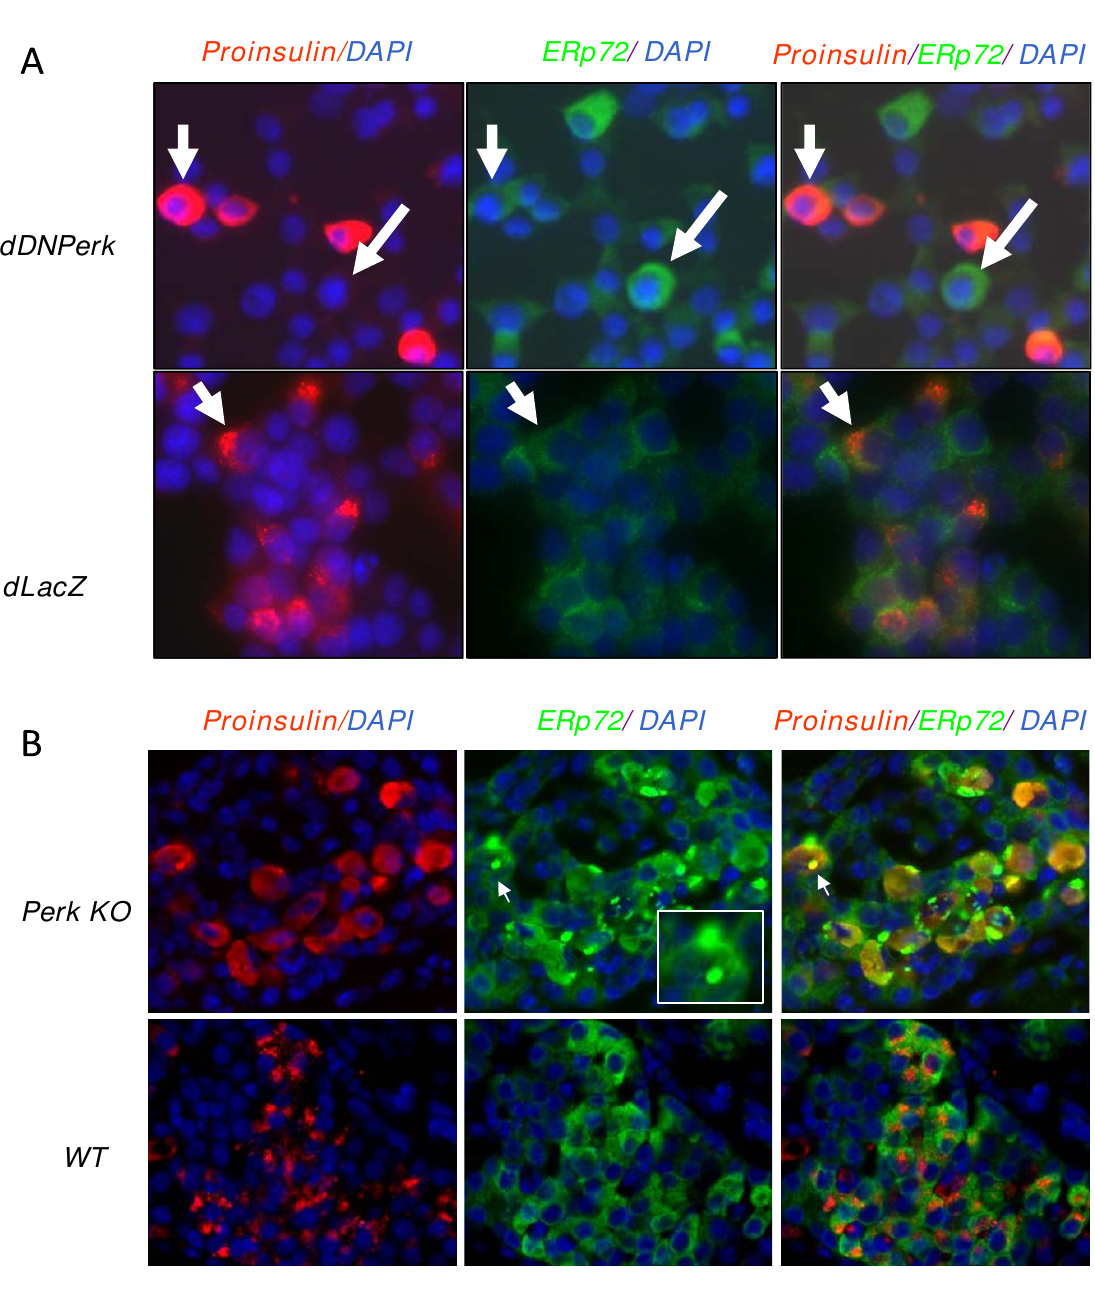
Figure 4 Ablation of PERK resulted in abnormal accumulation of proinsulin and ERp72 in beta cells . A. At 48 hr post-trans- duction, some of AdDNPerk -infected 832/13 cells had abnormal accumulation of proinsulin in the ER (upper panel, left arrow). ERp72 is upregulated in cells infected with AdDNPerk and the increase in ERp72 staining appeared earlier than the Impacted-ER phenotype (upper panel, right arrow). In contrast, cells infected with the AdLacZ -832/13 control exhibited normal Golgi locali- zation of proinsulin (lower panel, arrow). B. ERp72 is abnormally retained in Perk KO beta cells in neonatal P1 mice. Double staining for both proinsulin and ERp72 demonstrates higher expression of ERp72 in beta cells than in exocrine cells and other endocrine cells in both WT and KO. In KO cells the ERp72 antibody stains balloon-like structures (shown in the inset). The data represent three or more independent mice for each